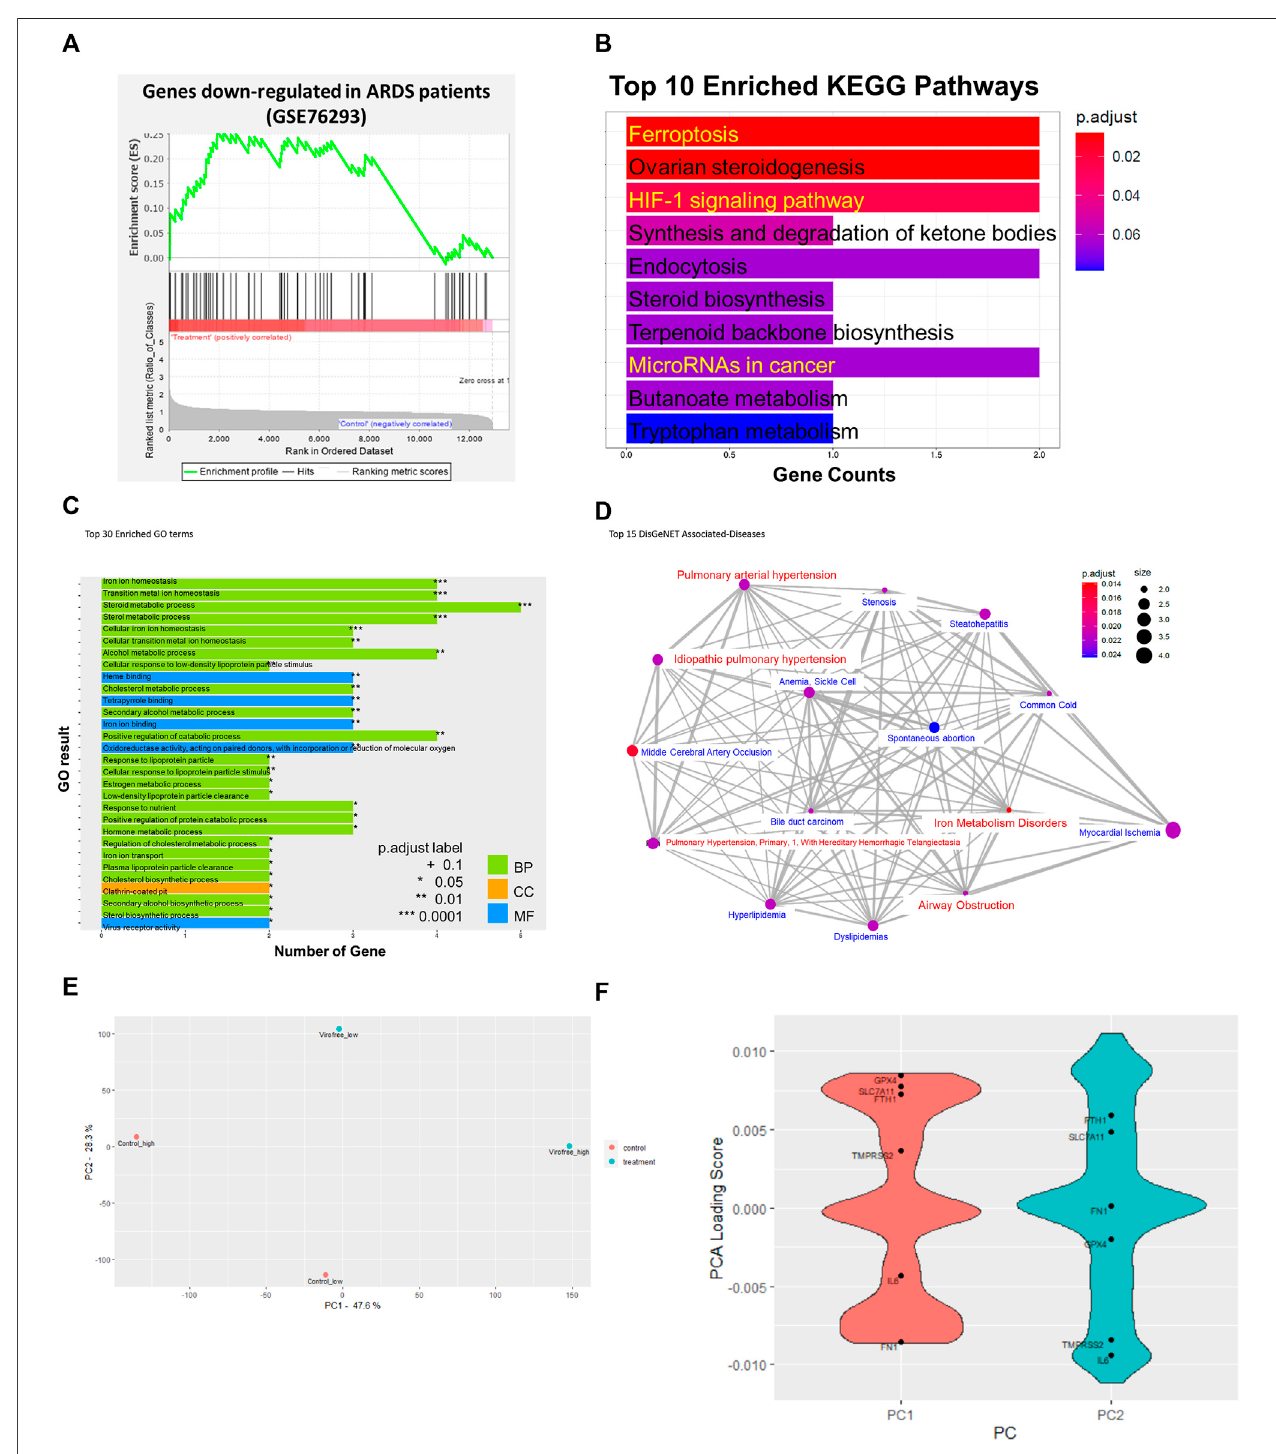
FIGURE1 | Bioinformatics analysisto identify the underlying mechanism of action of Virofree in the treatment of COVID-19. (A) GSEA enrichmentplot ofgene sets includingsigni fi cantlydownregulatedgenes(log2FC < − 1.5,adjusted p -value < 0.05)inpatients withARDS.Anegative enrichment score(NES)implies anenrichment in the downregulated genes by drug treatment. (B – D) bioinformatic analytics for low-dose (66.67 μ g/ml) transcriptome pro fi les of Virofree in BEAS-2B cells. (B) top 10 pathwaysfromKEGGenrichmentanalysisoftheDEGs.Thecolorintensitydenotesthe p -value,andthelengthofthebarindicatestheoverlappedgenesratio(gene counts) betweentheinputDEGsand thegeneset. (C) top30GeneOntology(GO)termenrichment.Thecolorindicatestheterm categoriesincluding biologicalprocess (BP), cellular component (CC), and molecular function (MF). The length of the bar indicates the overlapped gene number between the DEGs and GO terms. (D)